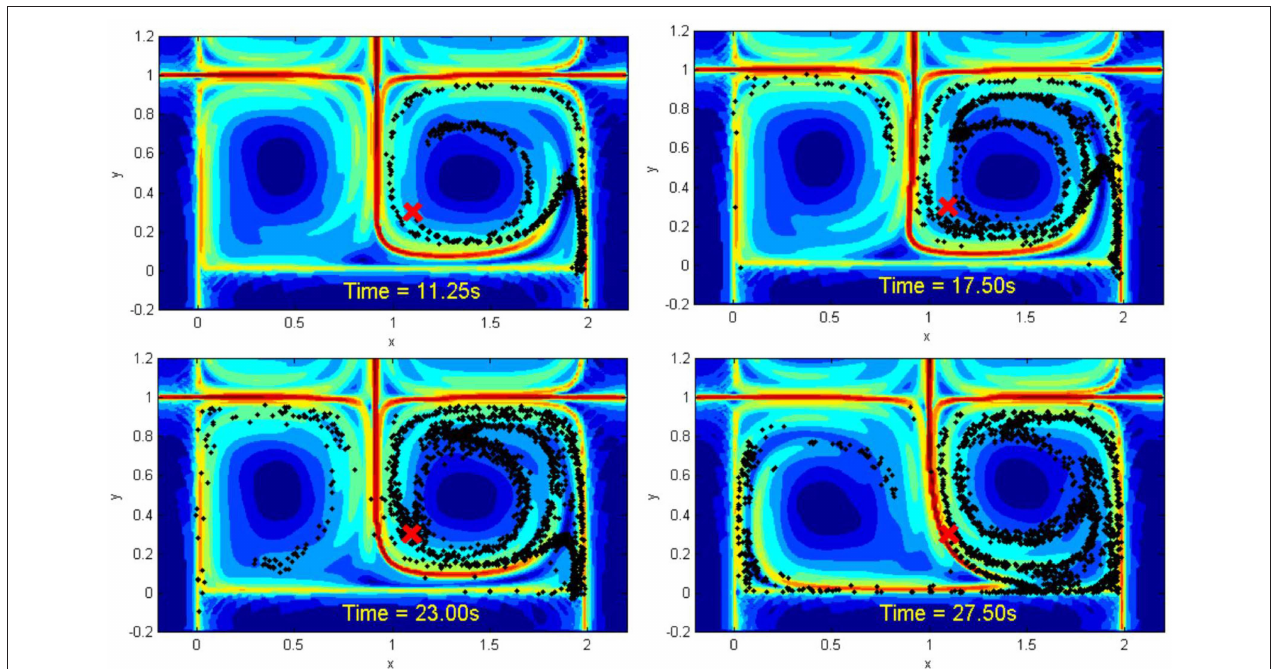
FIGURE 1 | Simulation of a contaminant spill in a time-varying wind-driven double-gyre flow. The LCS boundaries are shown as red curves and the red x denotes the source position of the spill. Black particles denote particulates emanating from the source. The center vertical LCS boundary oscillates horizontally about x